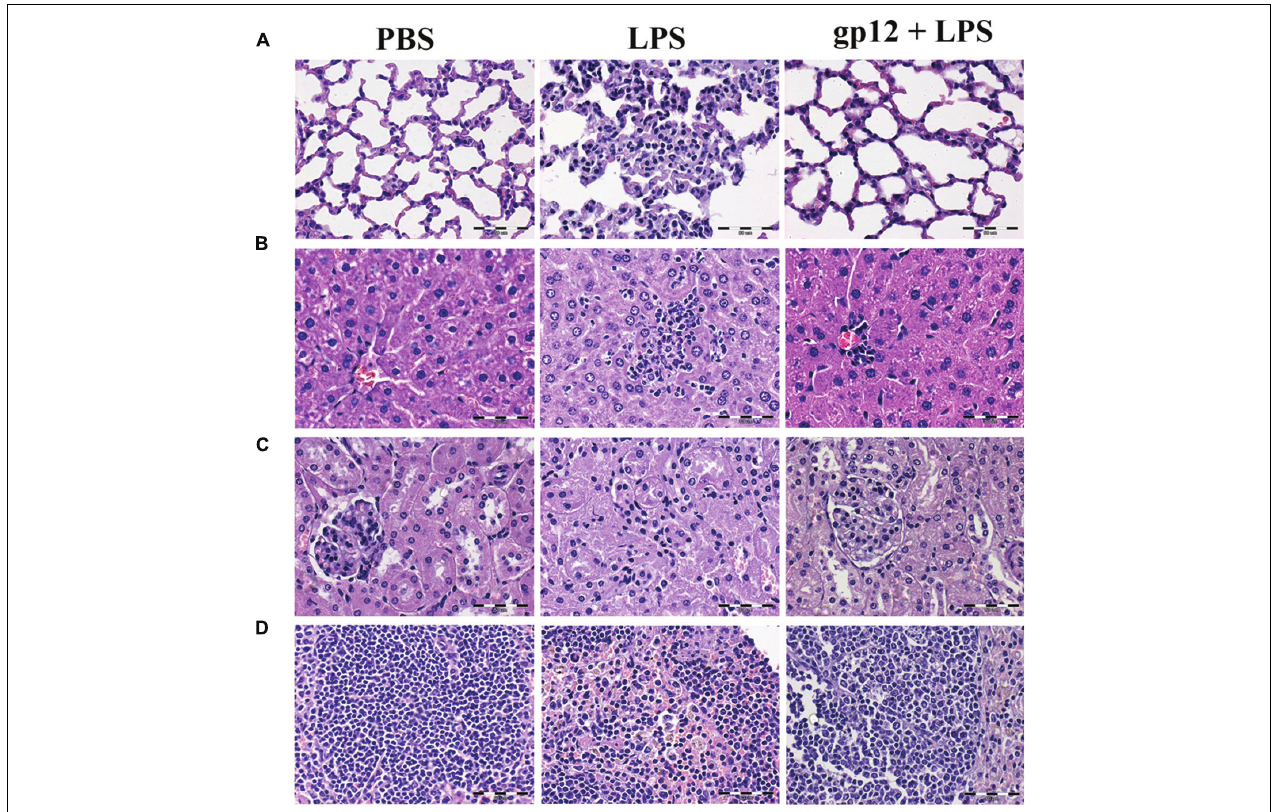
FIGURE 5 | Histopathological examination of selected animal tissues. (A) lungs; (B) liver; (C) kidneys; (D)